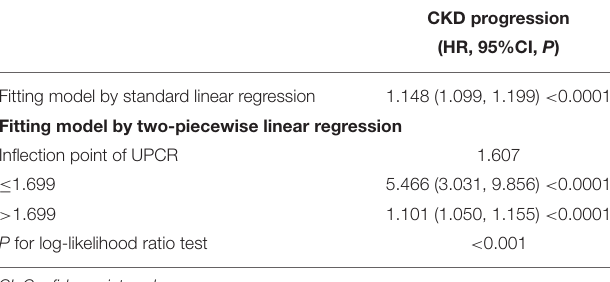
TABLE 6 | The result of the two-piecewise linear regression model in patients with UCPR > 0.3 for sensitivity